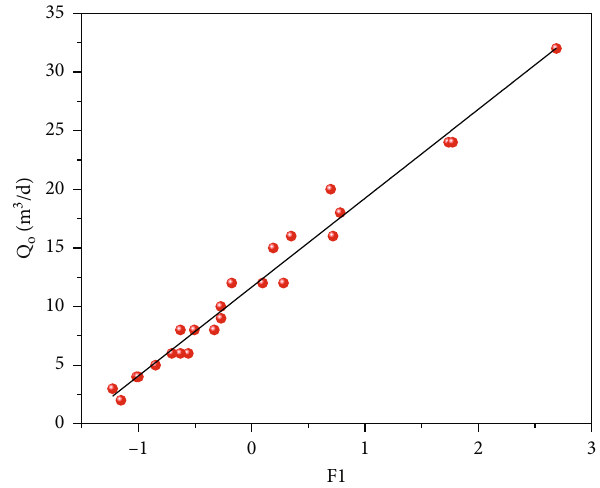
Figure 6: Diagram of relationship between Qo and F1.